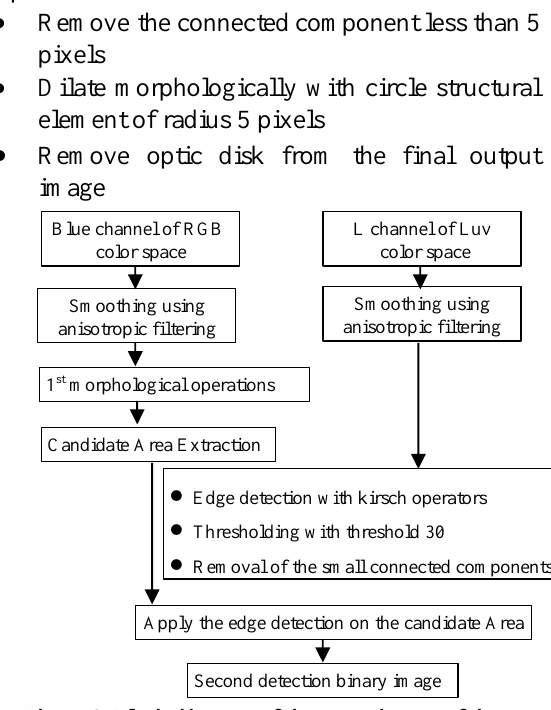
Figure 6. Block diagram of the second stage of the proposed detection